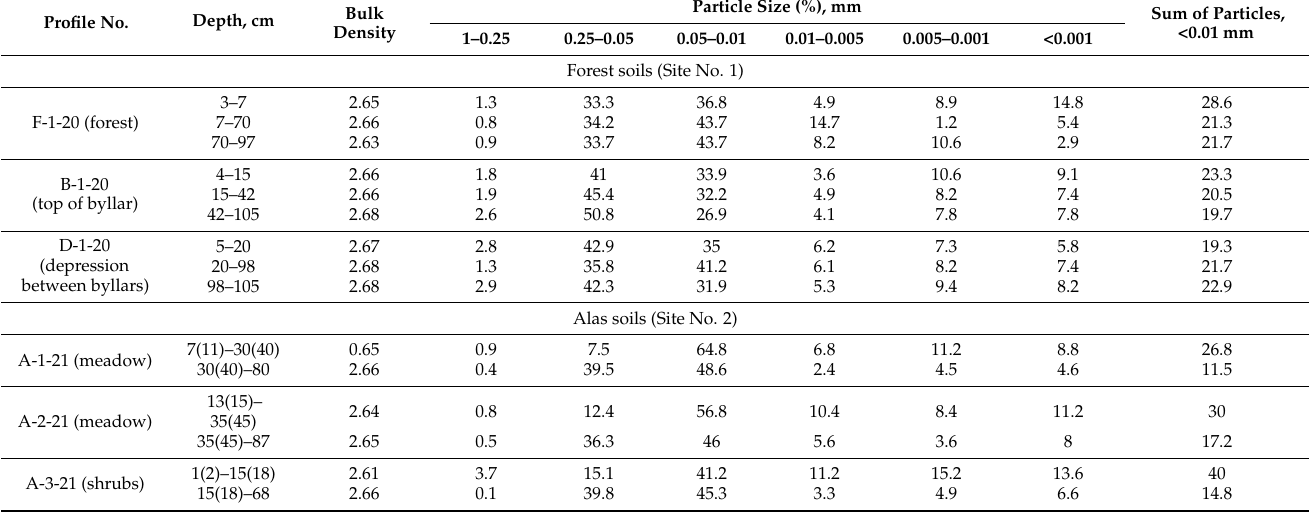
Table 3. Granulometric composition of studied